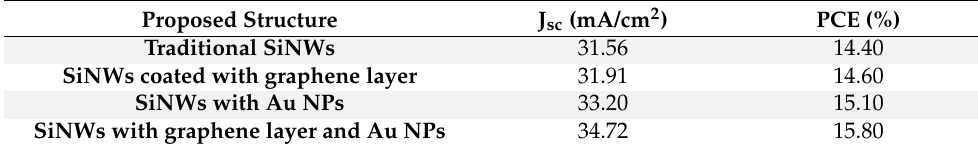
Table 2. Short-circuit current density and overall efficiency of the proposed four structures.